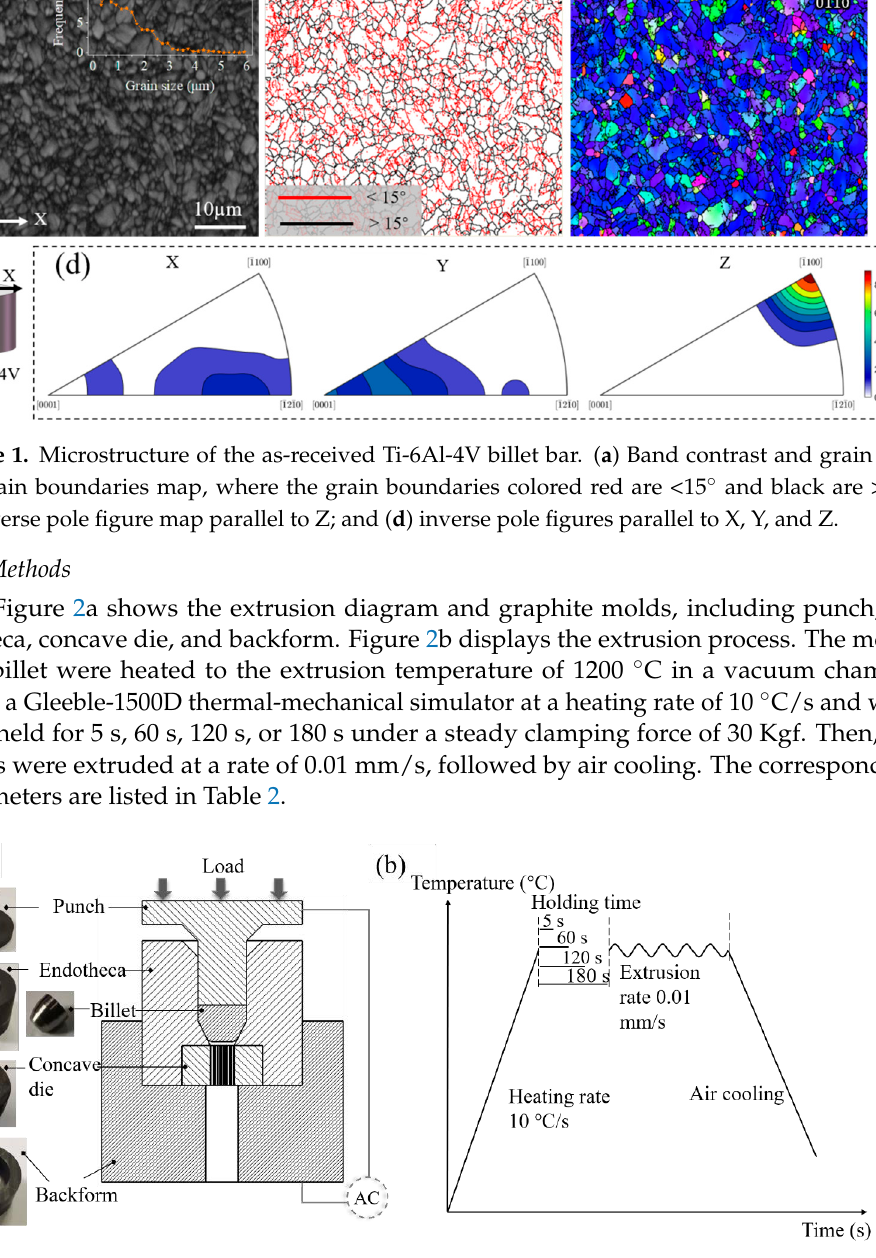
Figure 2. ( a ) Schematic diagram of forming Ti-6Al-4V micro-gear; ( b ) Processing route. Table 2. Extrusion parameters for each holding time Sample